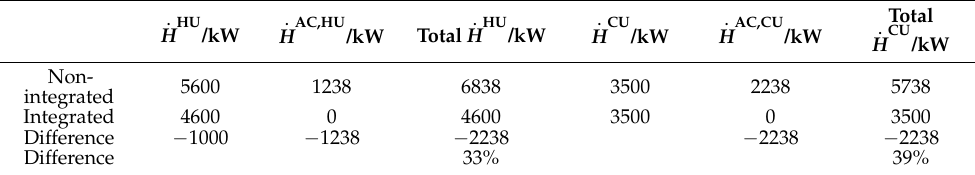
Table 8. Comparison of integrated and non-integrated solution for case study